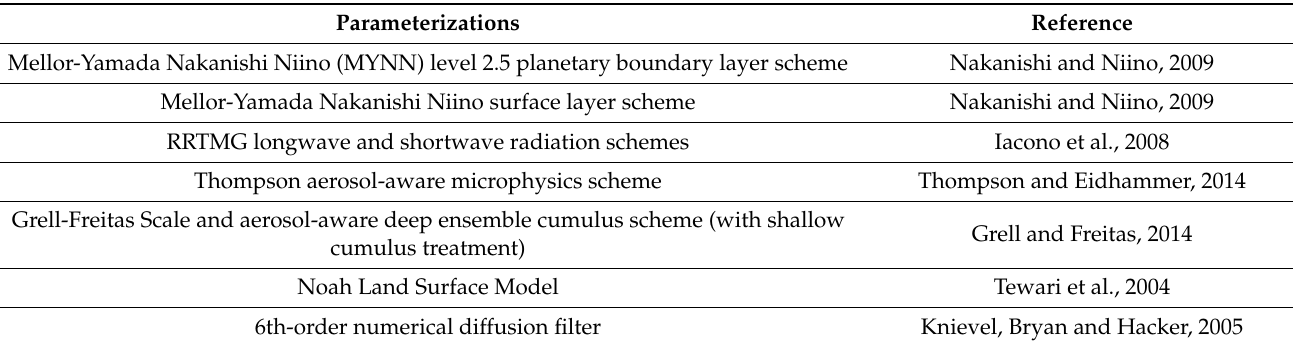
Table 1. Parametrizations used in WRF.